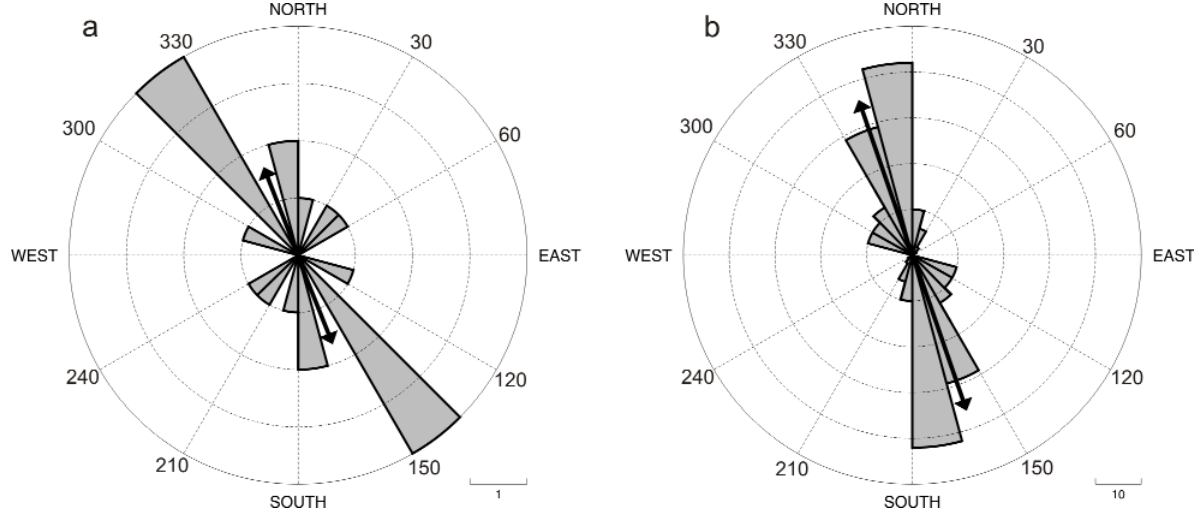
Figure 5. Rose diagrams of the fast shear-wave polarization directions before (a) and after (b) the Movri Mountain earthquake. The arrows represent the mean fast shear-wave polarization